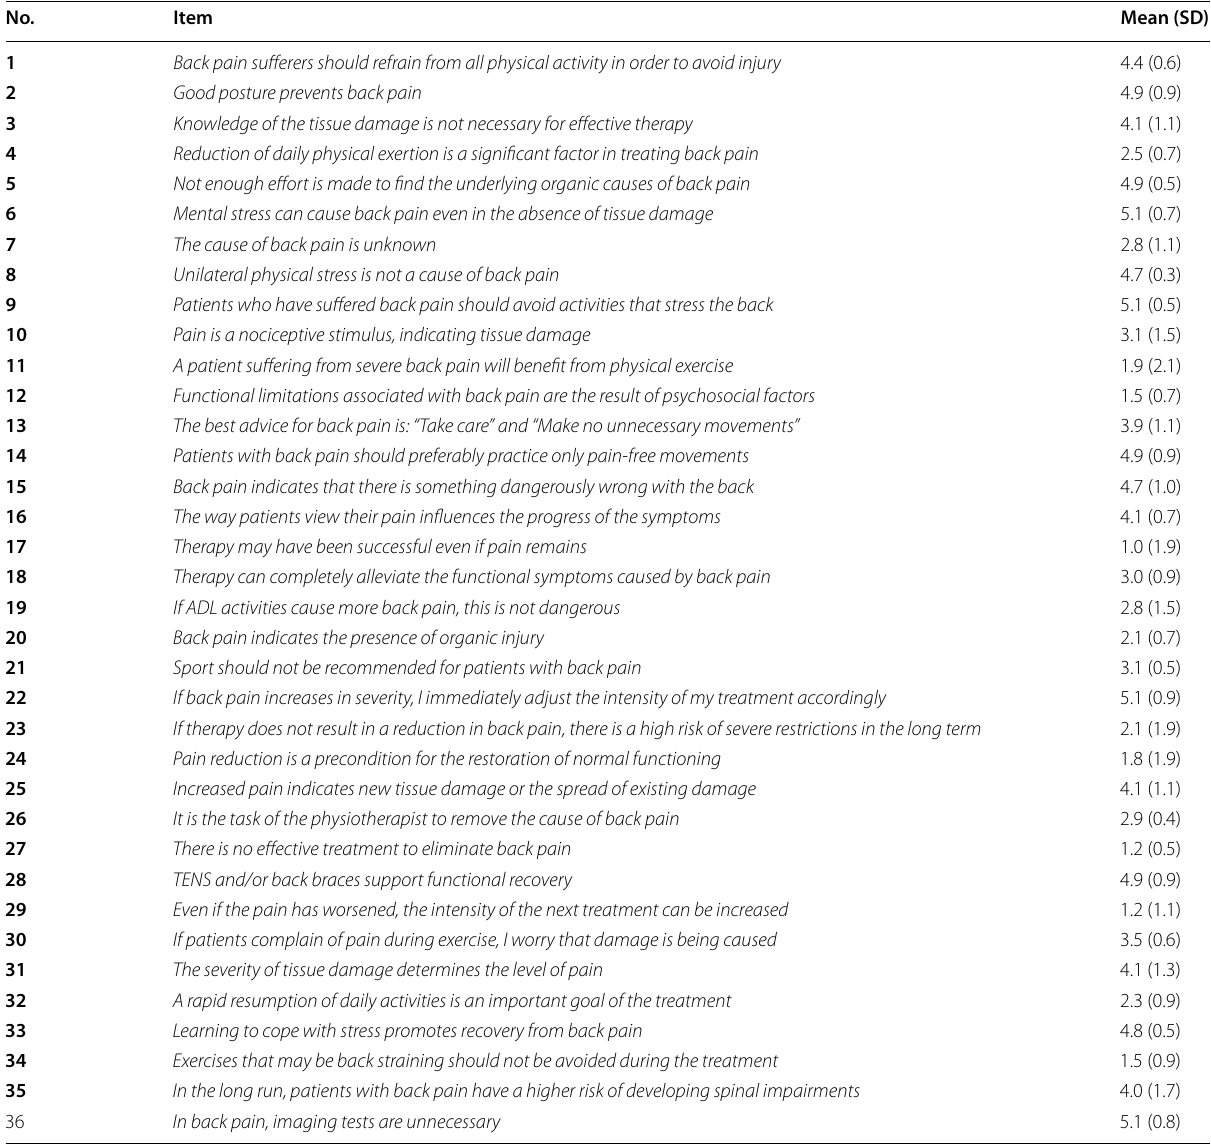
Table 2 Pain Attitudes and Beliefs Scale for Physiotherapist (PABS-PT)